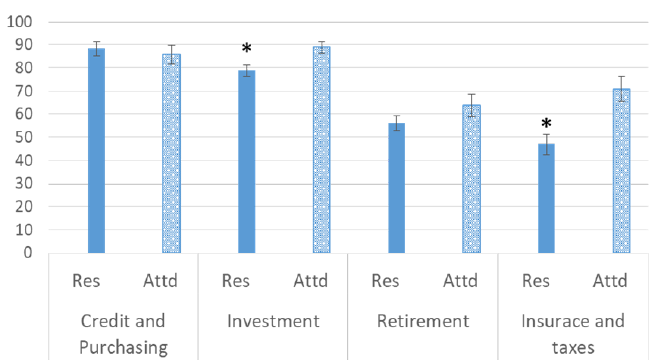
Figure 1. Average number of questions answered correctly on financial literacy test, stratified by topic and level of training. *P<0.01 Res , resident; Attd ,